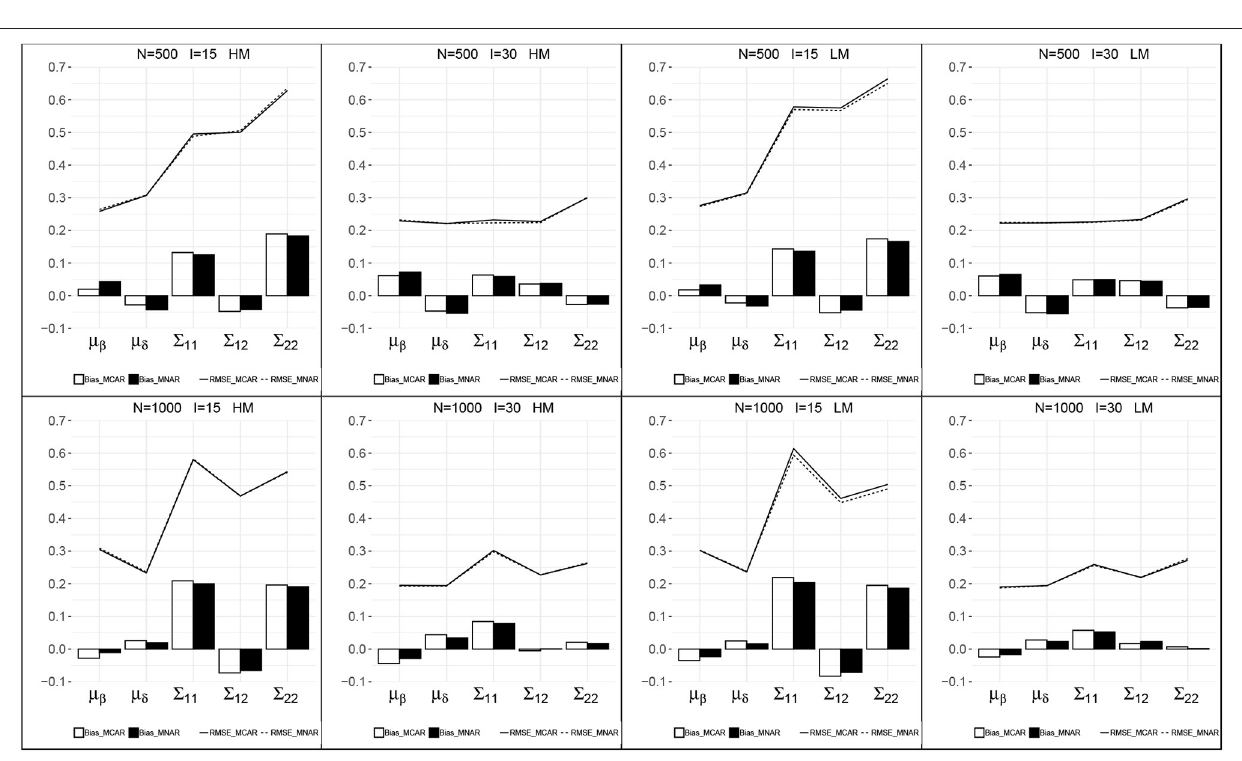
FIGURE 2 | Recovery of the parameters in the item mean vector and the item covariance matrix. HM, high missingness; LM, low